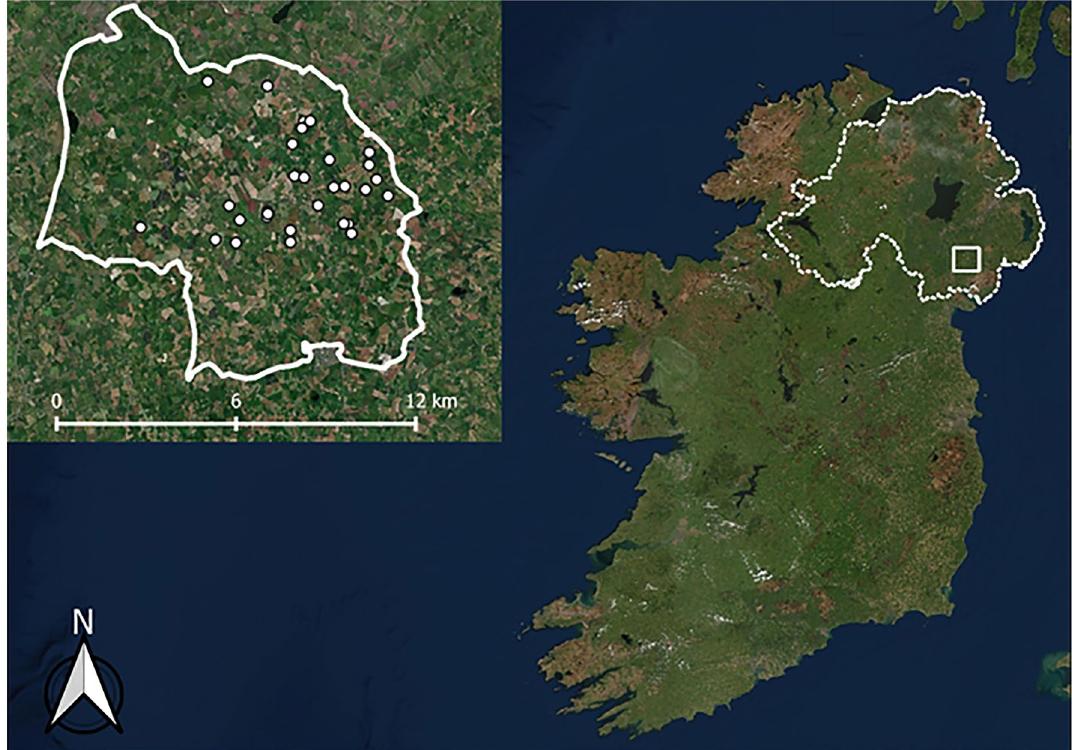
Figure 1. Map of study area in Northern Ireland (right) as shown by inset (left) created using QGIS version 3.8.1 (basemap satellite imagery ERSI World Imagery map) (https:// www. qgis. org/ en/ site/ and https:// www. arcgis. com/ home/ item. html? id= 10df2 279f9 684e4 a9f6a 7f08f ebac2 a9). Location of the study area relative to the whole of Ireland is shown in by a white border. White dots denote trapping